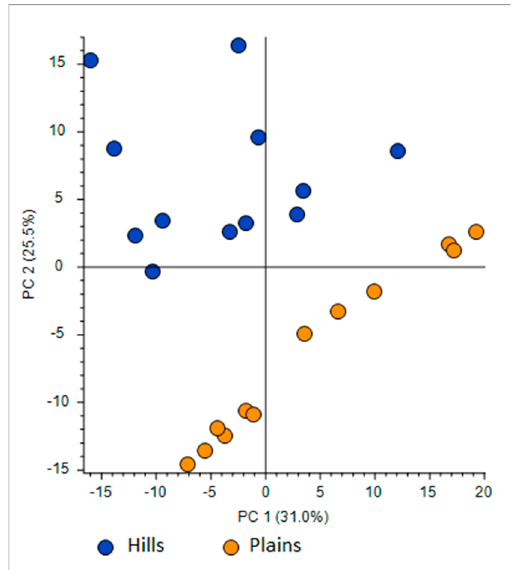
Figure 6. Principal Component Analysis (PCA) projection on the distribution of samples respect to PC-1 with PC-2 when high resolution mass spectrometry (HRMS) spectra were used.